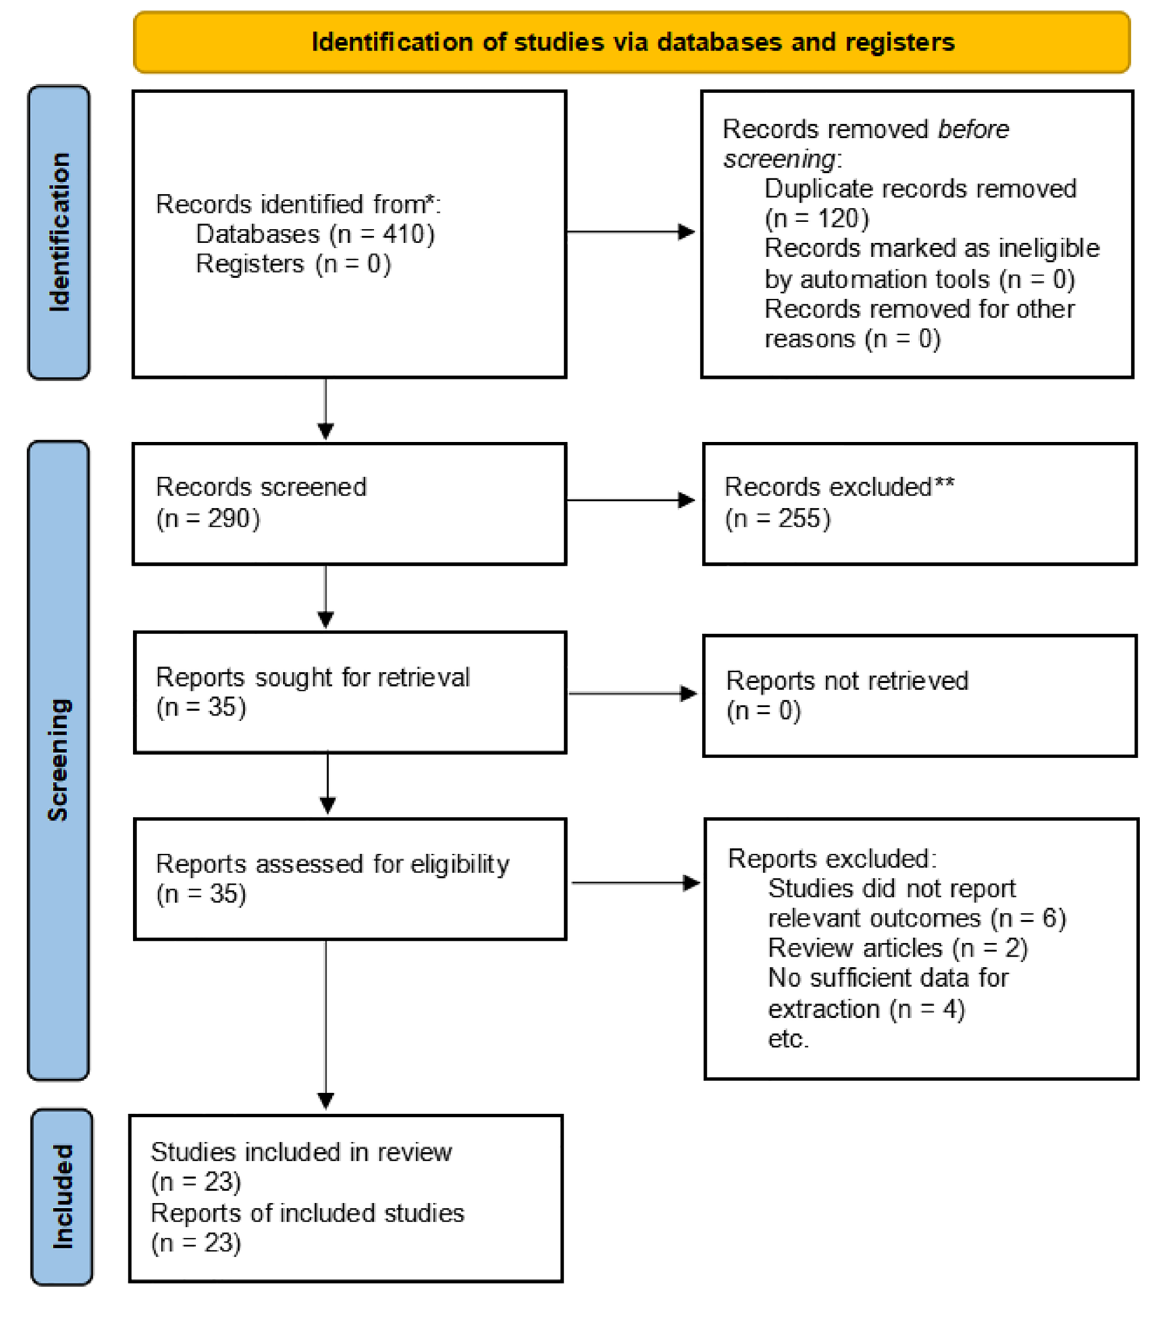
Figure 1 - Flow diagram of literature searches according to the preferred reporting items for systematic reviews and meta- analyses